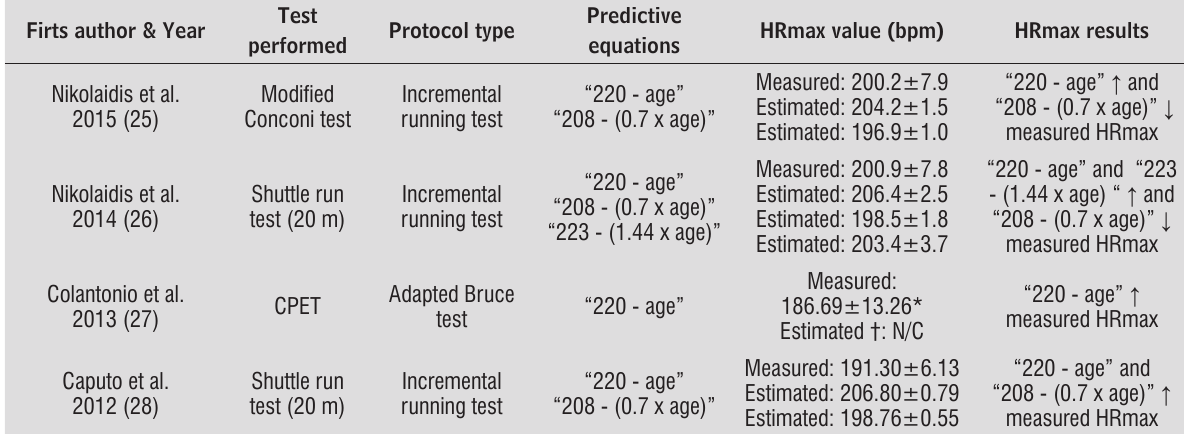
Table 2 - Characteristics and main results of the studies included in this